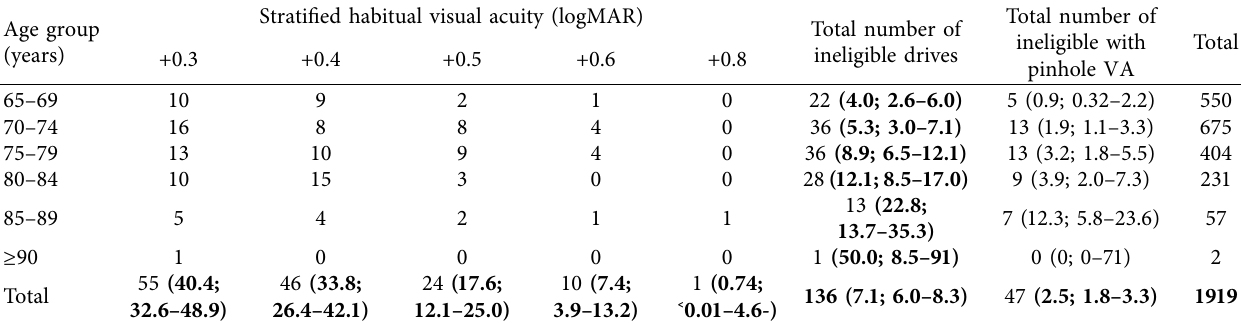
Table 2: Variation of VA level among all drivers who fall below the DVLA VA minimum requirement, stratified for age. Age